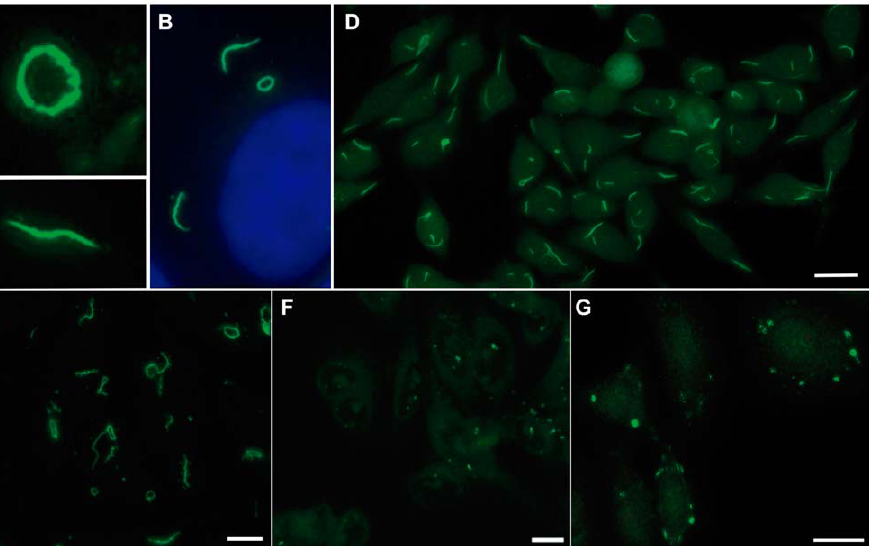
Figure 1. IIF-HEp-2 rods and rings pattern in different slide brands. Indirect immunofluorescence with a representative anti-RR-positive HCV patient sample diluted 1/80. A, B, and C, slides from Euroimmun at 6 1,000 magnification. (A) Ring conformation example; (B) Rod conformation example; (C) Cell with both conformations, depicting the cytoplasmic localization underscored by DAPI staining of the nucleus. (D) Classical RR pattern in INOVA slides, depicting a variable number of 3–10 m m long rods and 2–5 m m diameter rings in the cytoplasm. (E) Typical RR configuration in home-made slides with HEp-2 cells treated with 2 mM ribavirin for 24 h. Non-specific cytoplasmic dots in non-treated home-made HEp-2 slides (F) and in Bion HEp-2 slides (G), respectively. White bar: 20 m m.